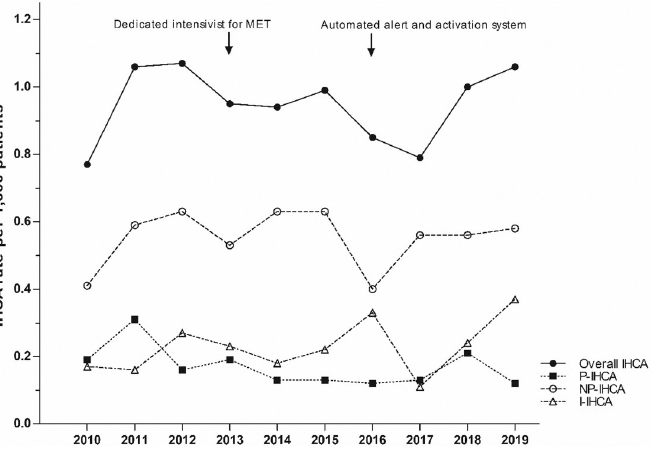
Fig 2. Annual trend of in-hospital cardiac arrests (IHCAs) by classification. P-IHCA, preventable in-hospital cardiac arrest; NP-IHCA, non-preventable in-hospital cardiac arrest; I-IHCA, inevitable in-hospital cardiac arrest.